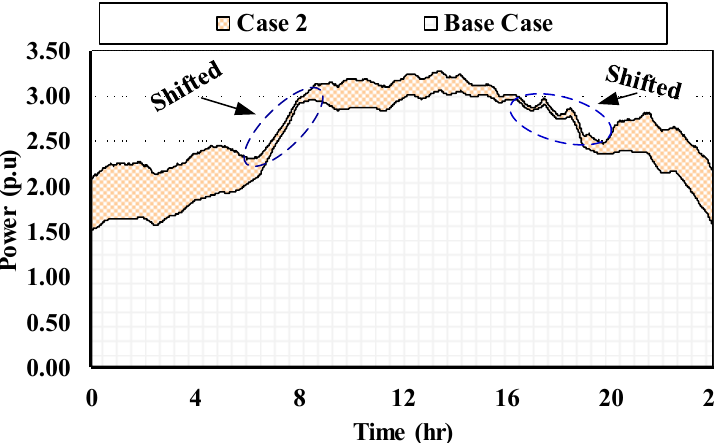
Figure 11. Normal distribution for owner’s preferences 400 EVs.